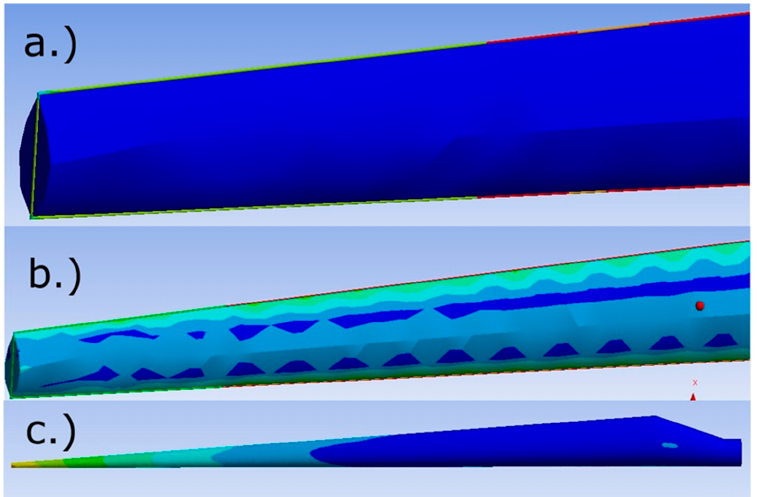
Figure 6. Graphical simulation results, hybrid design (case study E); ( a ) current density in the conductor, ( b ) temperature generated by current, ( c ) deformation caused by